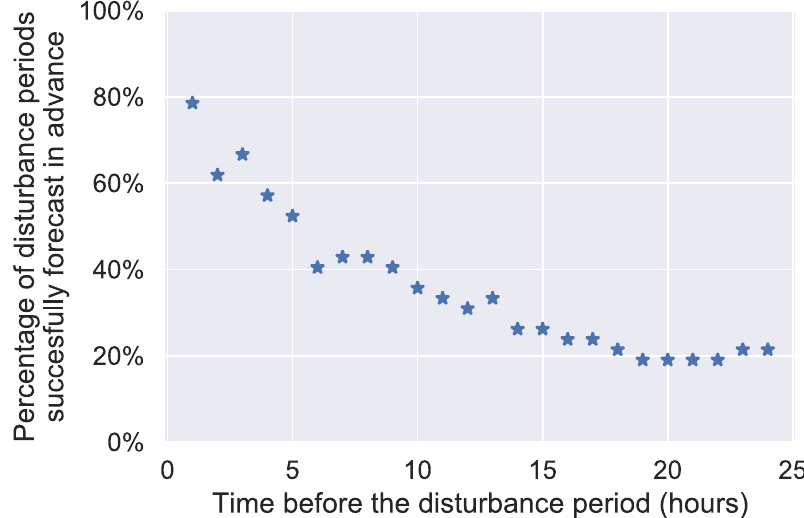
Fig. 8. Percentage of times the 24 h-binary classi fi cation problem was correctly forecast during quiet periods previous to a threshold exceedance depending on how much time (from 1 h to 24 h) there was left before the